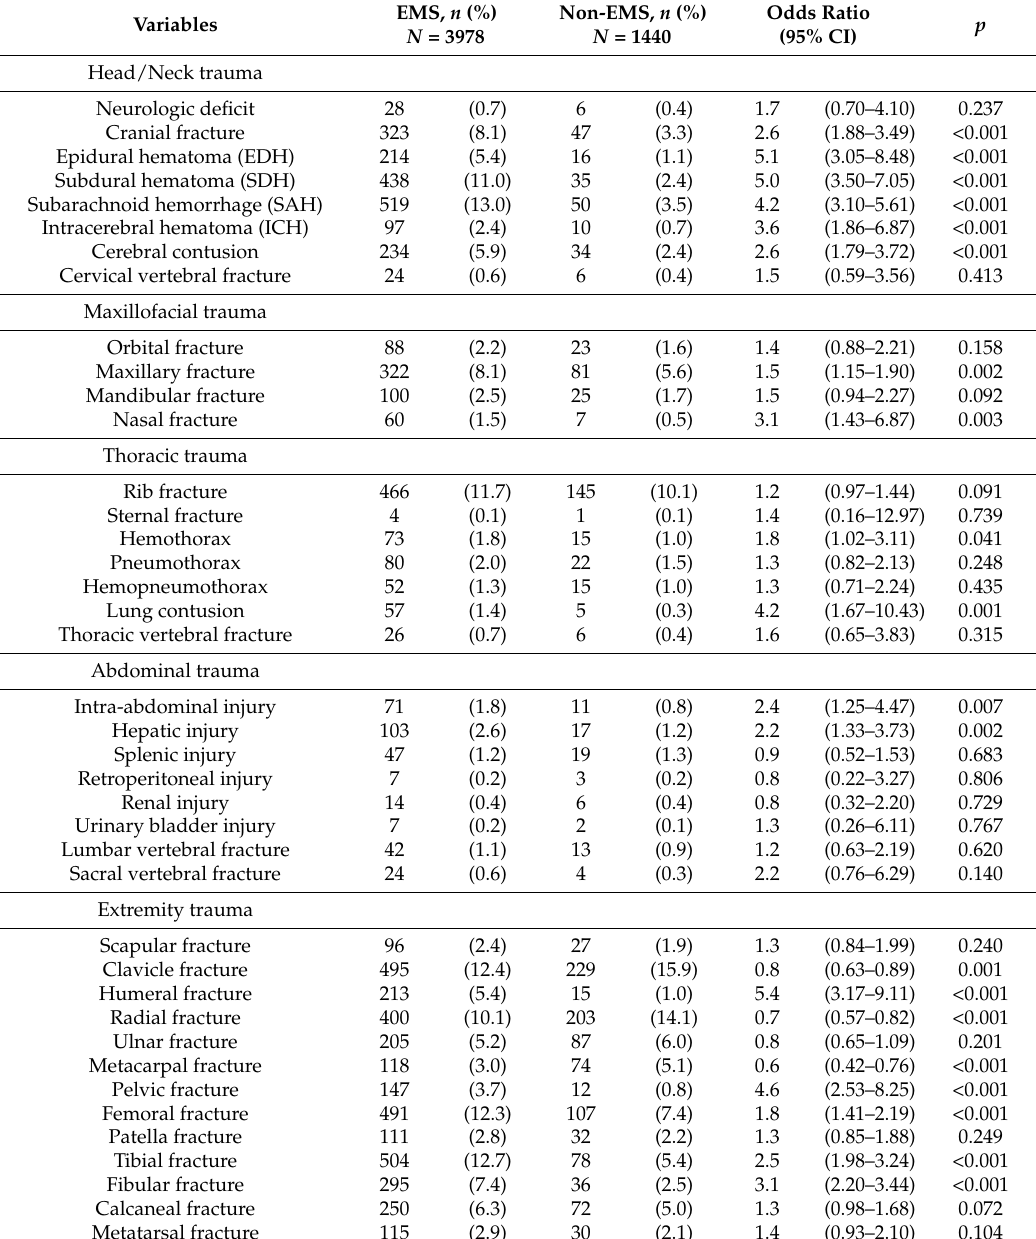
Table S1. Injuries of the patients transported by Emergency Medical Services (EMS) and